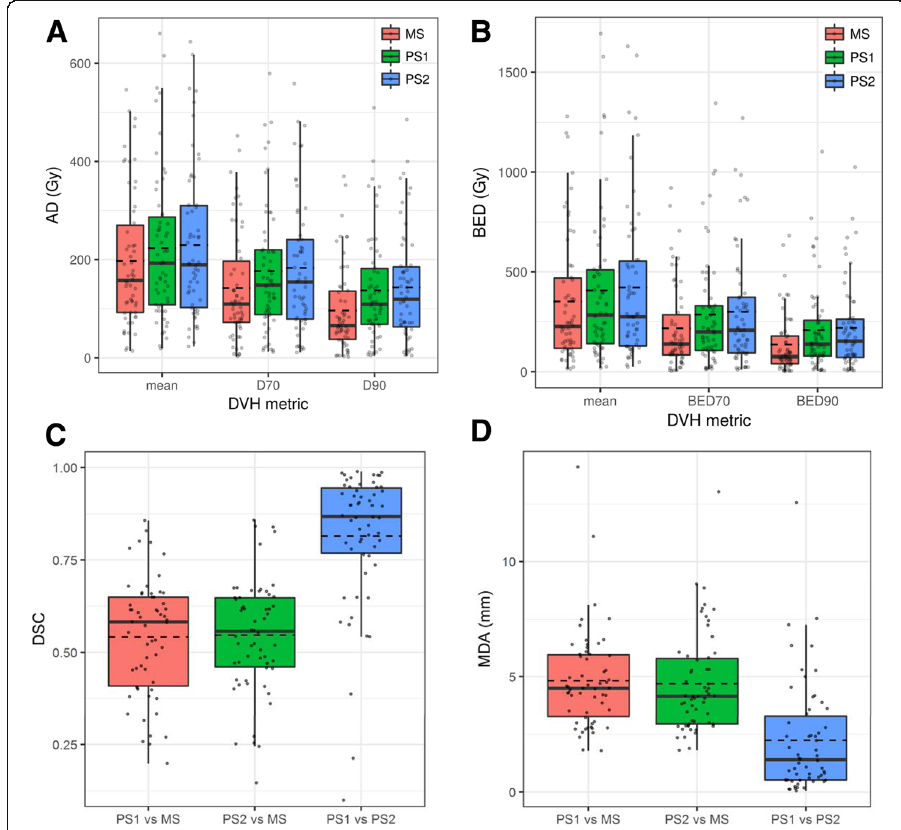
Fig. 3 Boxplots summarizing the tumor AD ( a ) and BED ( b ) DVH metrics for MS, PS1, and PS2. Spatial concordance is summarized in boxplots using DSC ( c ) and MDA ( d ). For boxplots, the solid black line represents the median and dashed line represents the mean. The bottom and top of the box represent the 1st (Q1) and 3rd (Q3) quartile. Whiskers extend to the largest (or smallest) value within 1.5*(Q3 − Q1) + Q3 for largest (Q1 − 1.5 * Q3 − Q1) for